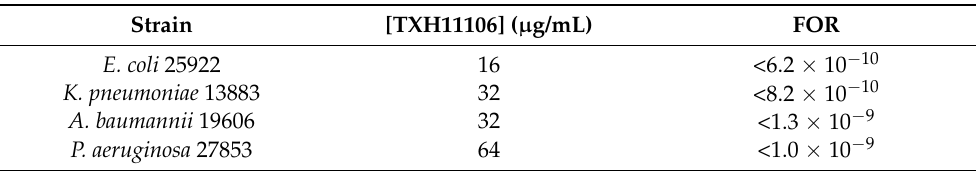
Table 2. Frequency of resistance (FOR) in E. coli , K. pneumoniae , A. baumannii , and P. aeruginosa upon exposure to